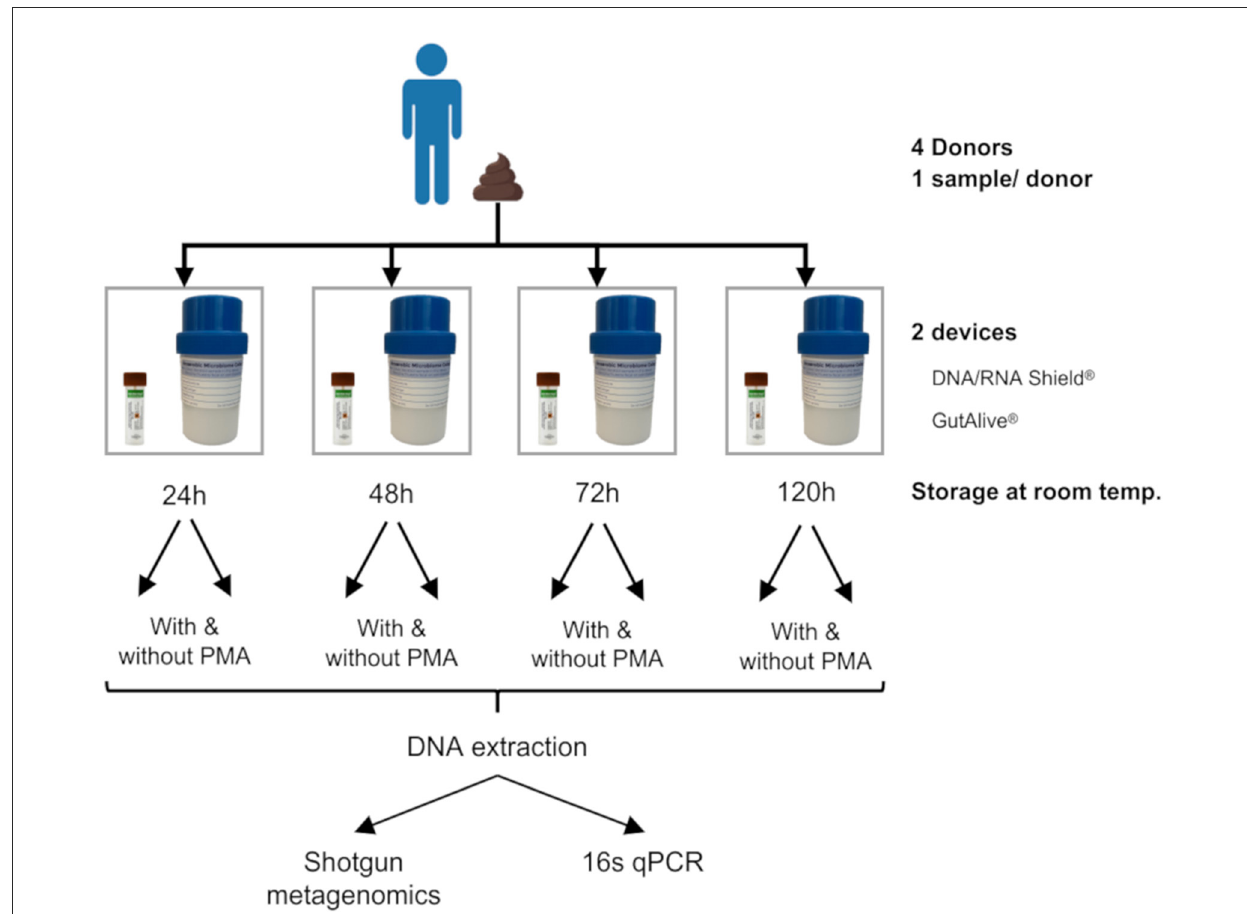
FIGURE1 Experimental design. One stool sample was self-collected by each donor (with a total of four donors). Each fecal sample was divided into eight subsamples by the donor at the time of deposition, four of which were collected with DNA/RNA Shield ® and the other four with GutAlive ® . Samples were processed at 24, 48, 72, and 120h at room temperature, treated with or without PMA. The DNA was extracted from each sample to perform shotgun metagenomics and 16s